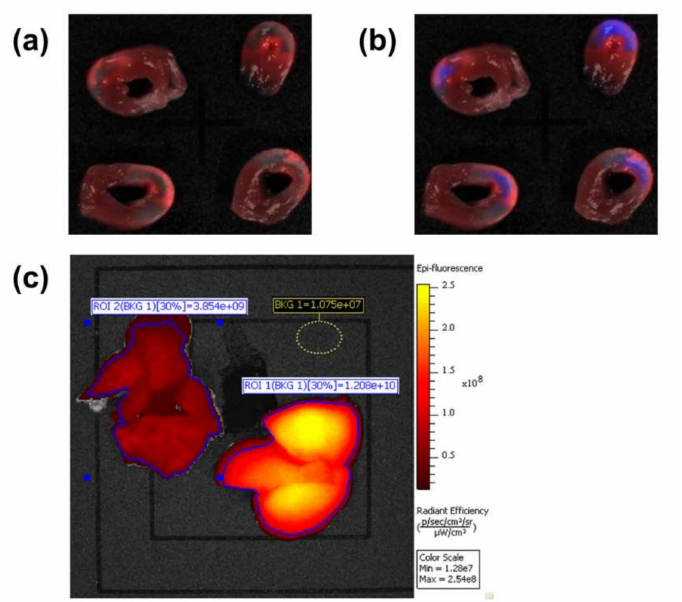
Figure 12. Investigation of internal organ slices harvested from laboratory animals by fluorescence tomography: ( a ) heart slices, ICG filter; ( b ) heart slices, spectral combination of filters ICG and GFP; ( c ) lung (left) and liver (right), (background, BKG